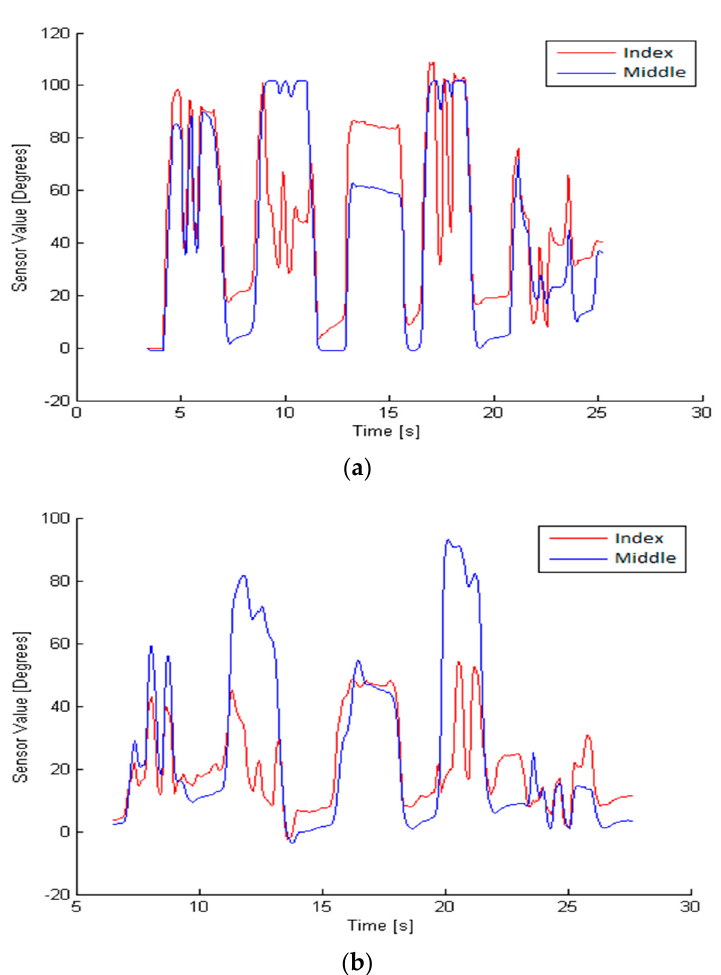
Figure 4. Sensor values during the performance of the movements represented in Table 1 in the same order. ( a ) person 1, and ( b ) person 2.